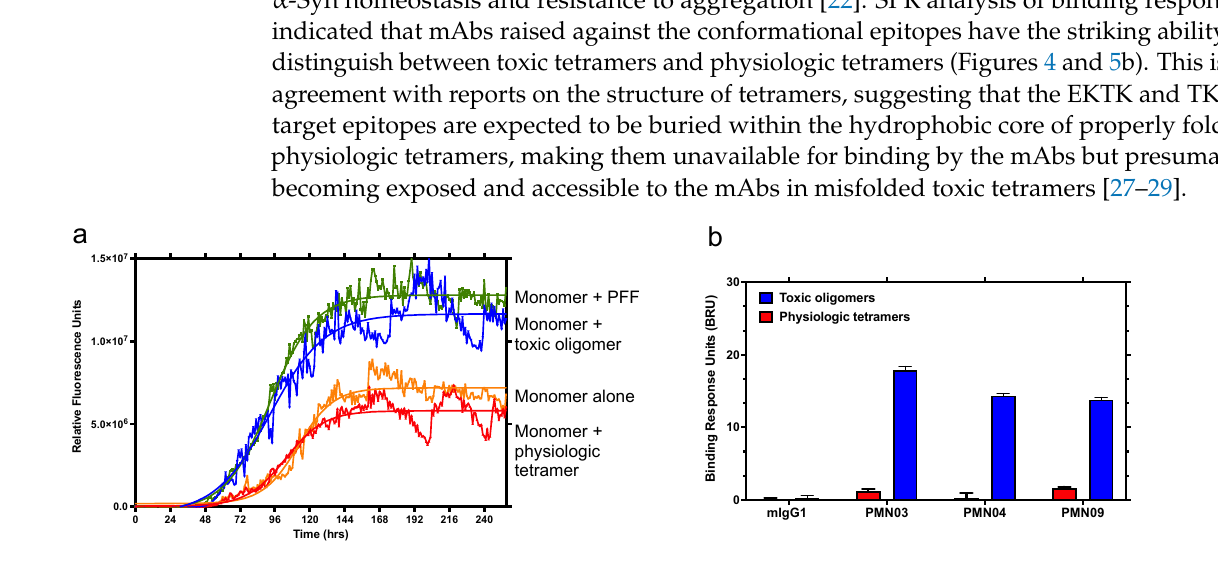
9 of 18 Figure 4. Selective binding of mAbs to pathogenic species of α -syn by SPR. The binding response of immobilized mAbs to α -syn monomers, toxic oligomers, soluble (sonicated) PFFs and physiologic (Phys.) tetramers was measured by SPR. An antibody reactive with all species of α -syn (Pan α -syn) was used as a positive control. The same pattern of binding was observed in 4 independent experiments.